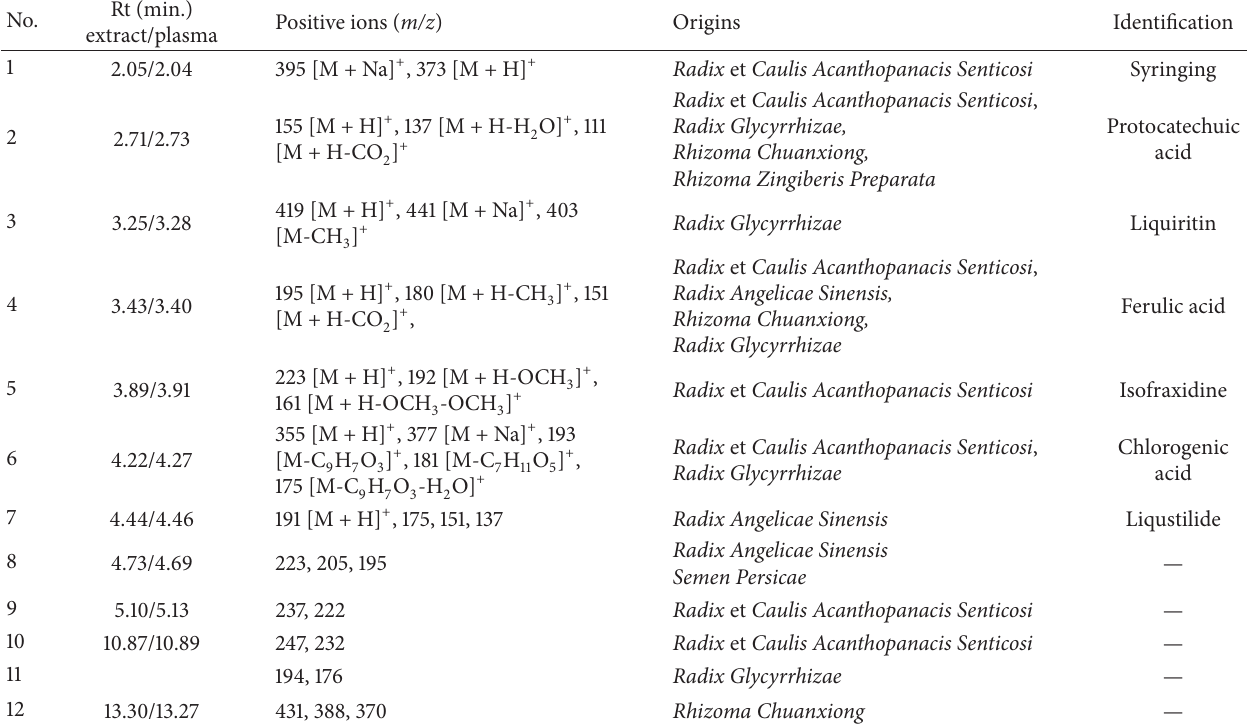
Table 2: The retention times, +ESI-MS/MS data ( m/z ), and origins of the absorbed components in rat serum after oral administration of WJSH capsule.